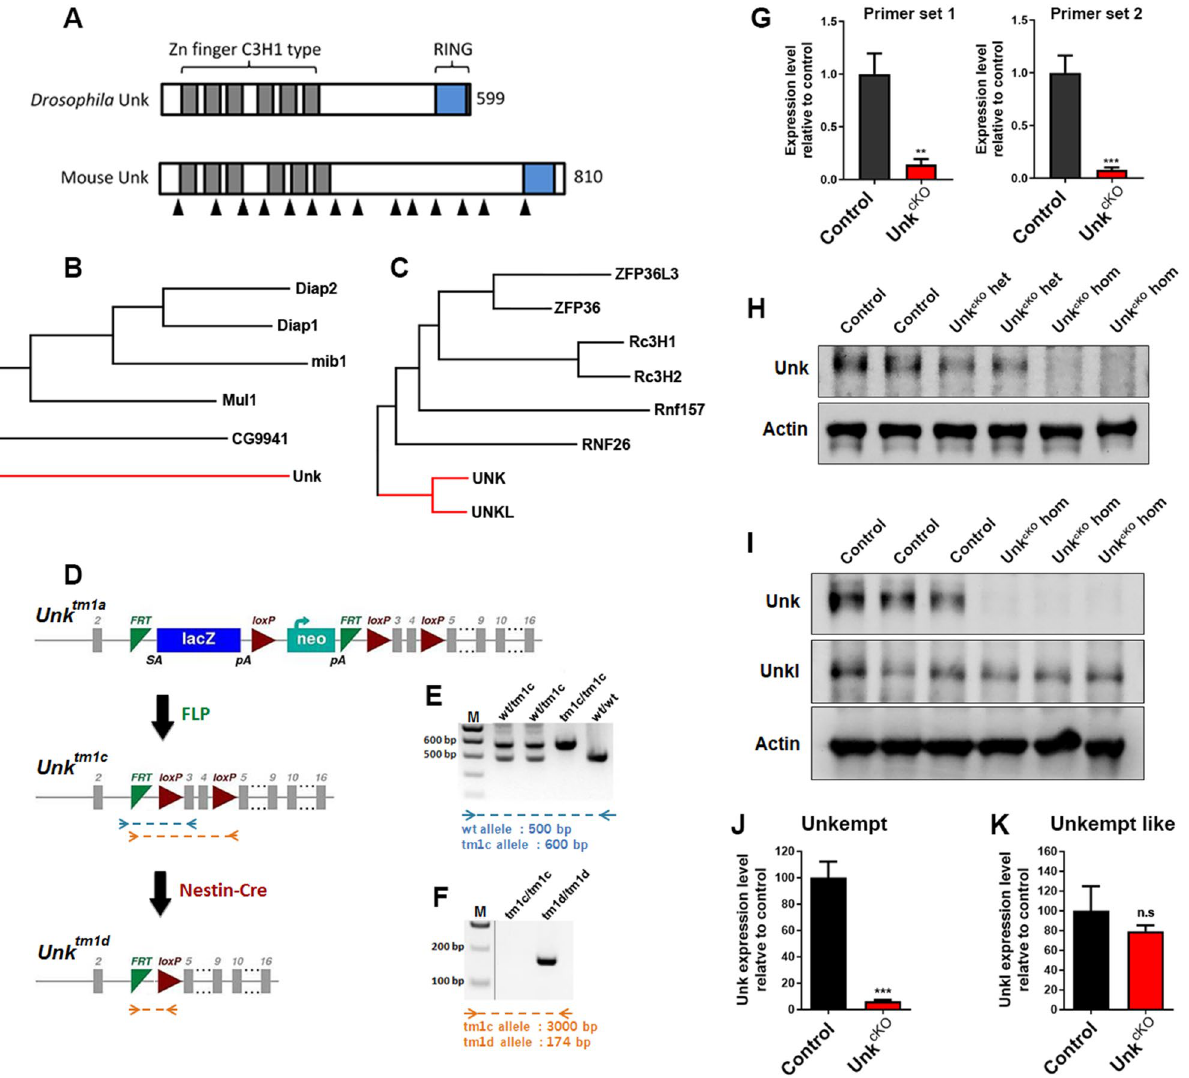
Figure 1. Generation of an Unkempt nervous system conditional knockout mouse. ( A ) Schematic of the primary structure of Drosophila and mouse Unkempt proteins. ( B , C ) Dendrograms showing evolutionary relationship between Drosophila Unkempt and closely related proteins ( B ) and mouse Unkempt and Unkempt like and closely related proteins ( C ). ( D ) Generation of the Unk cKO allele. The Unk tm1a knockout first conditional ready cassette, which contains a lacZ reporter and neomycin (neo) resistance gene flanked by FRT sites, was converted to the Unk tm1c allele by crossing to mice expressing FLP recombinase, and further converted to the conditional allele Unk tm1d ( Unk cKO ) by crossing to mice expressing Nestin-Cre recombinase. Grey boxes represent exons. SA = splice acceptor site, pA = poly-adenylation tail. Dotted lines represent primer binding sites for PCR reactions shown in ( E ) and ( F ). ( E ) Example genotyping of the Unk tm1c allele. The remaining FRT and loxP sites increase the size of the Unk tm1c allele PCR product by 100 bp compared to wild-type. ( F ) Example genotyping of the Unk tm1d allele. Removal of the critical exons creates a PCR product of 174 bp in size. M = molecular weight marker. ( G ) qRT-PCR analysis of E16.5 CNS tissue from control ( Unk tm1c/tm1c ) and deleted genomic region. Control n = 5, Unk cKO n = 5. ( H ) Western blot of Unkempt (Unk) expression in E16.5 Unkempt like (Unkl) expression in control and Unk cKO E16.5 CNS tissue. ( J , K ) Quantification of Unkempt (Unk) and Unkempt like (Unkl) expression. Data are presented as mean ± SEM. Student’s t test, n.s. not significant, ** p < 0.05, *** p < 0.001. Control n = 3, Unk cKO n =